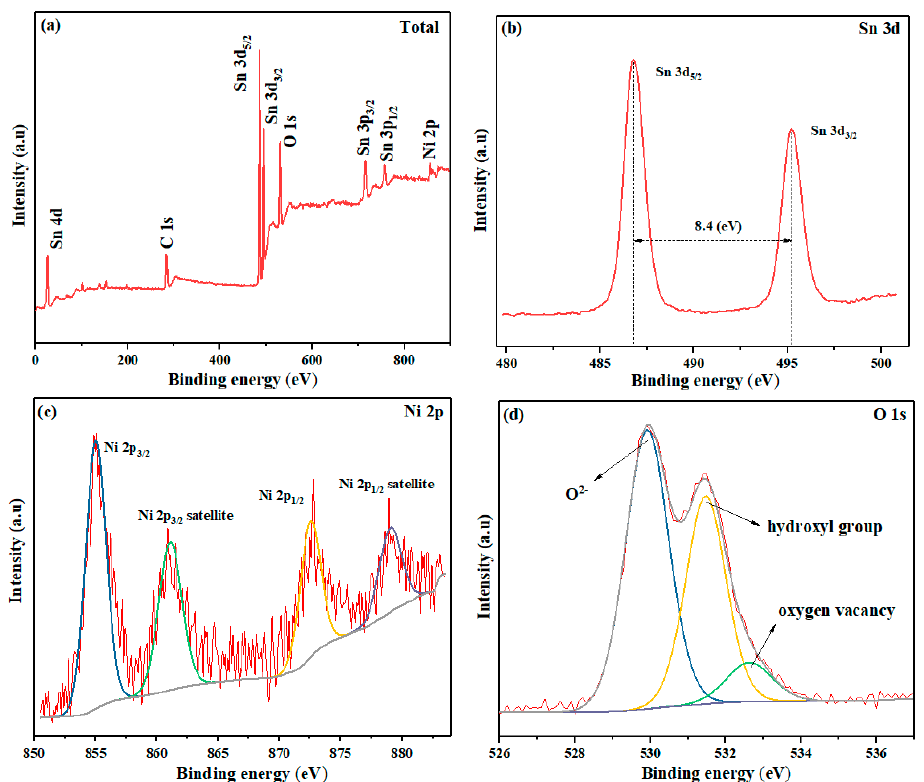
Figure 5. X-ray photoelectron spectroscopy (XPS) spectra of ( a ) total, ( b ) Sn, ( c ) Ni and ( d ) O for NiSn/4 sample.